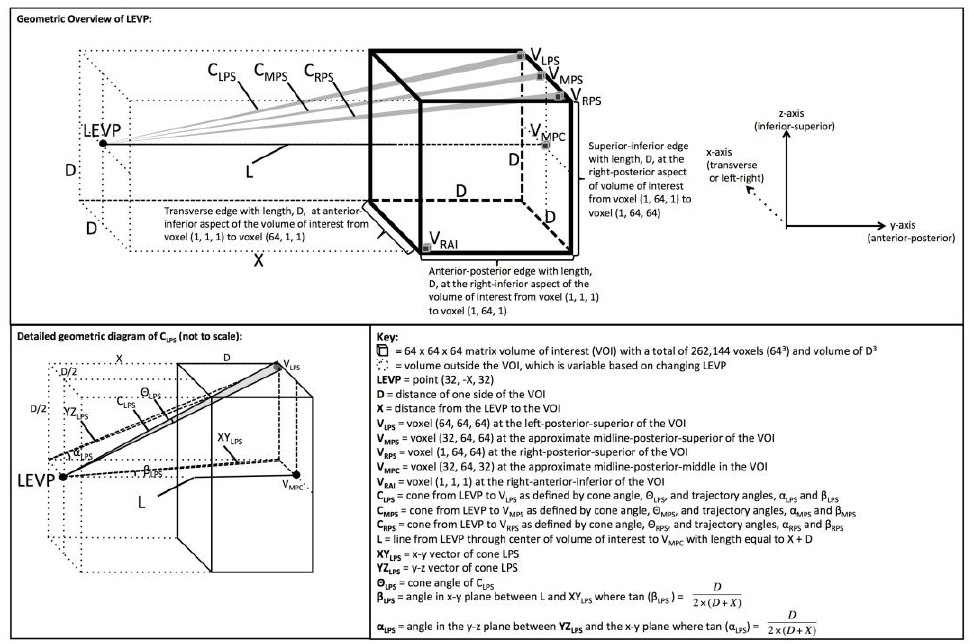
Figure 4. This is an overview of the depth 3-dimensional (D3D) processing system for the left eye viewing perspective [15]. Reprinted from Journal of Medical Devices: Evidence and Research , Volume 9, Douglas et al. “D3D augmented reality imaging system: proof of concept in mammography”, 277–283, 2016 with permission from Dove Medical Press Ltd.